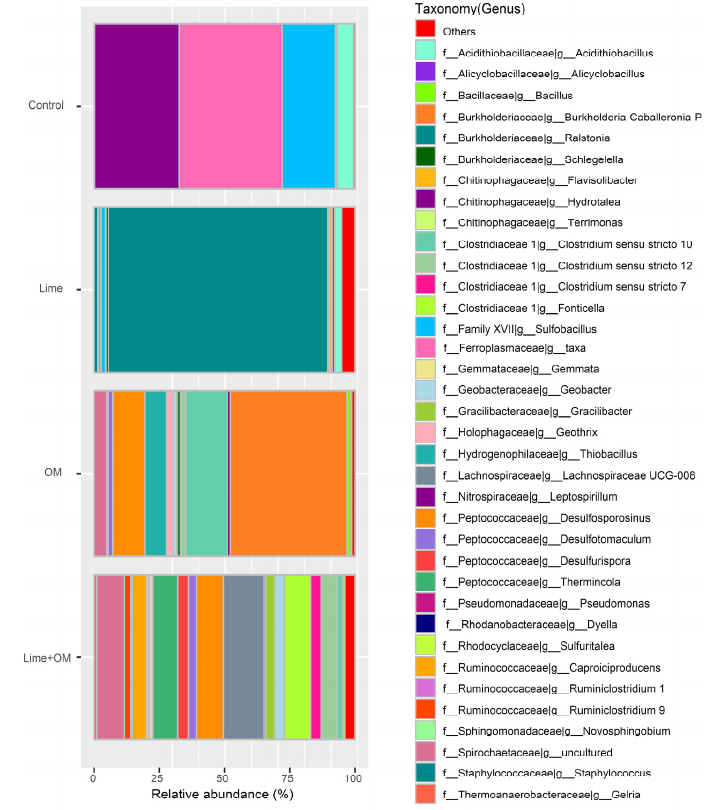
Figure 6. Genus of the microbial community in the residue of the four columns (control, Lime, OM, and Lime + OM) at the end of the incubation of 180 days.